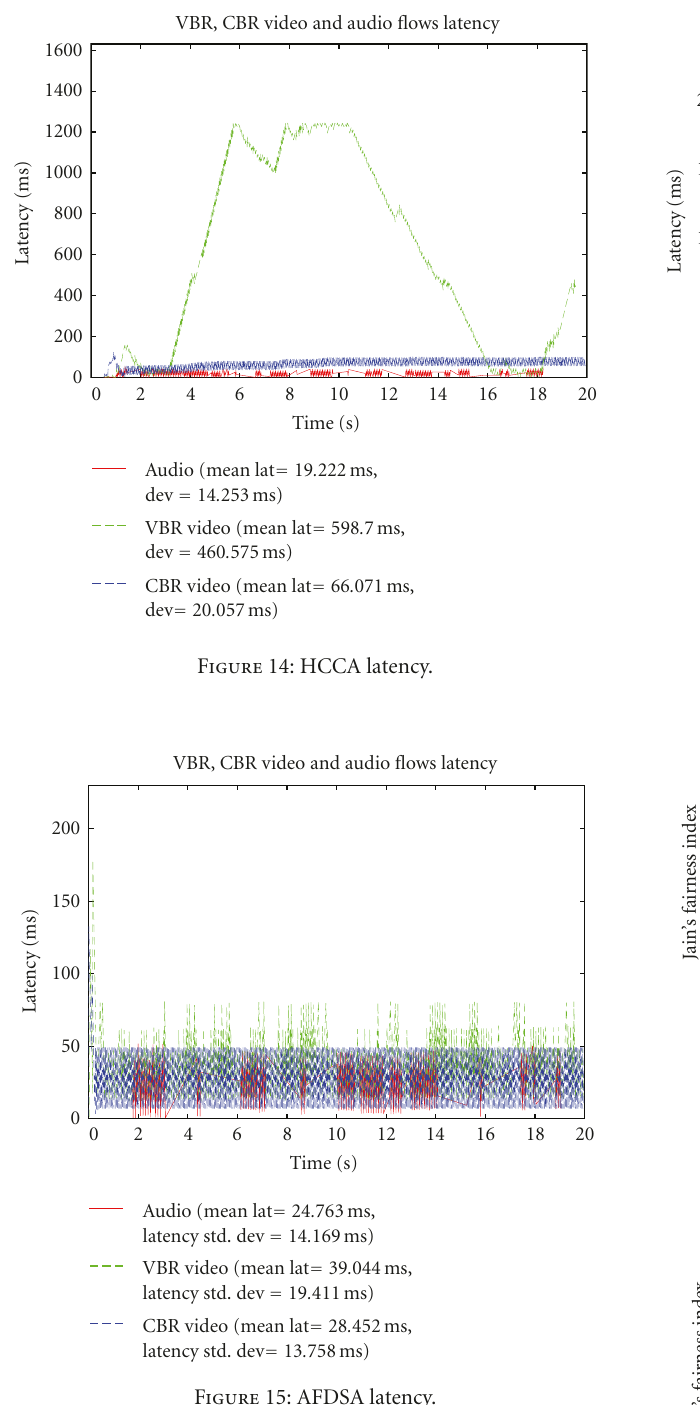
Figure 15: AFDSA latency.